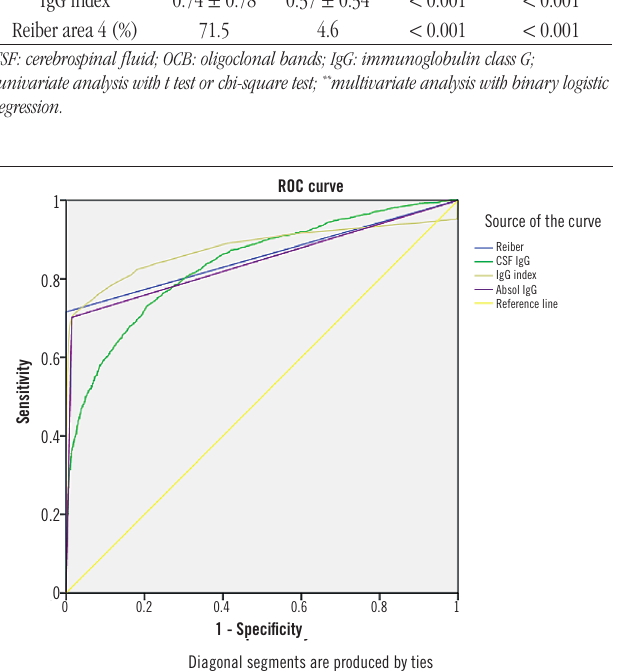
figure – ROC curves of IgG index, Reiber diagram, CSF IgG, and gamma globulin fraction ability to predict OCB+